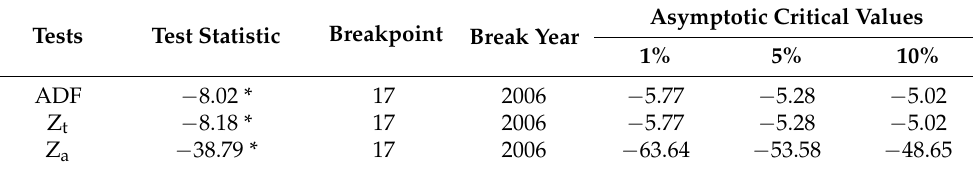
Table 8. Gregory–Hansen test for cointegration with regime shifts.